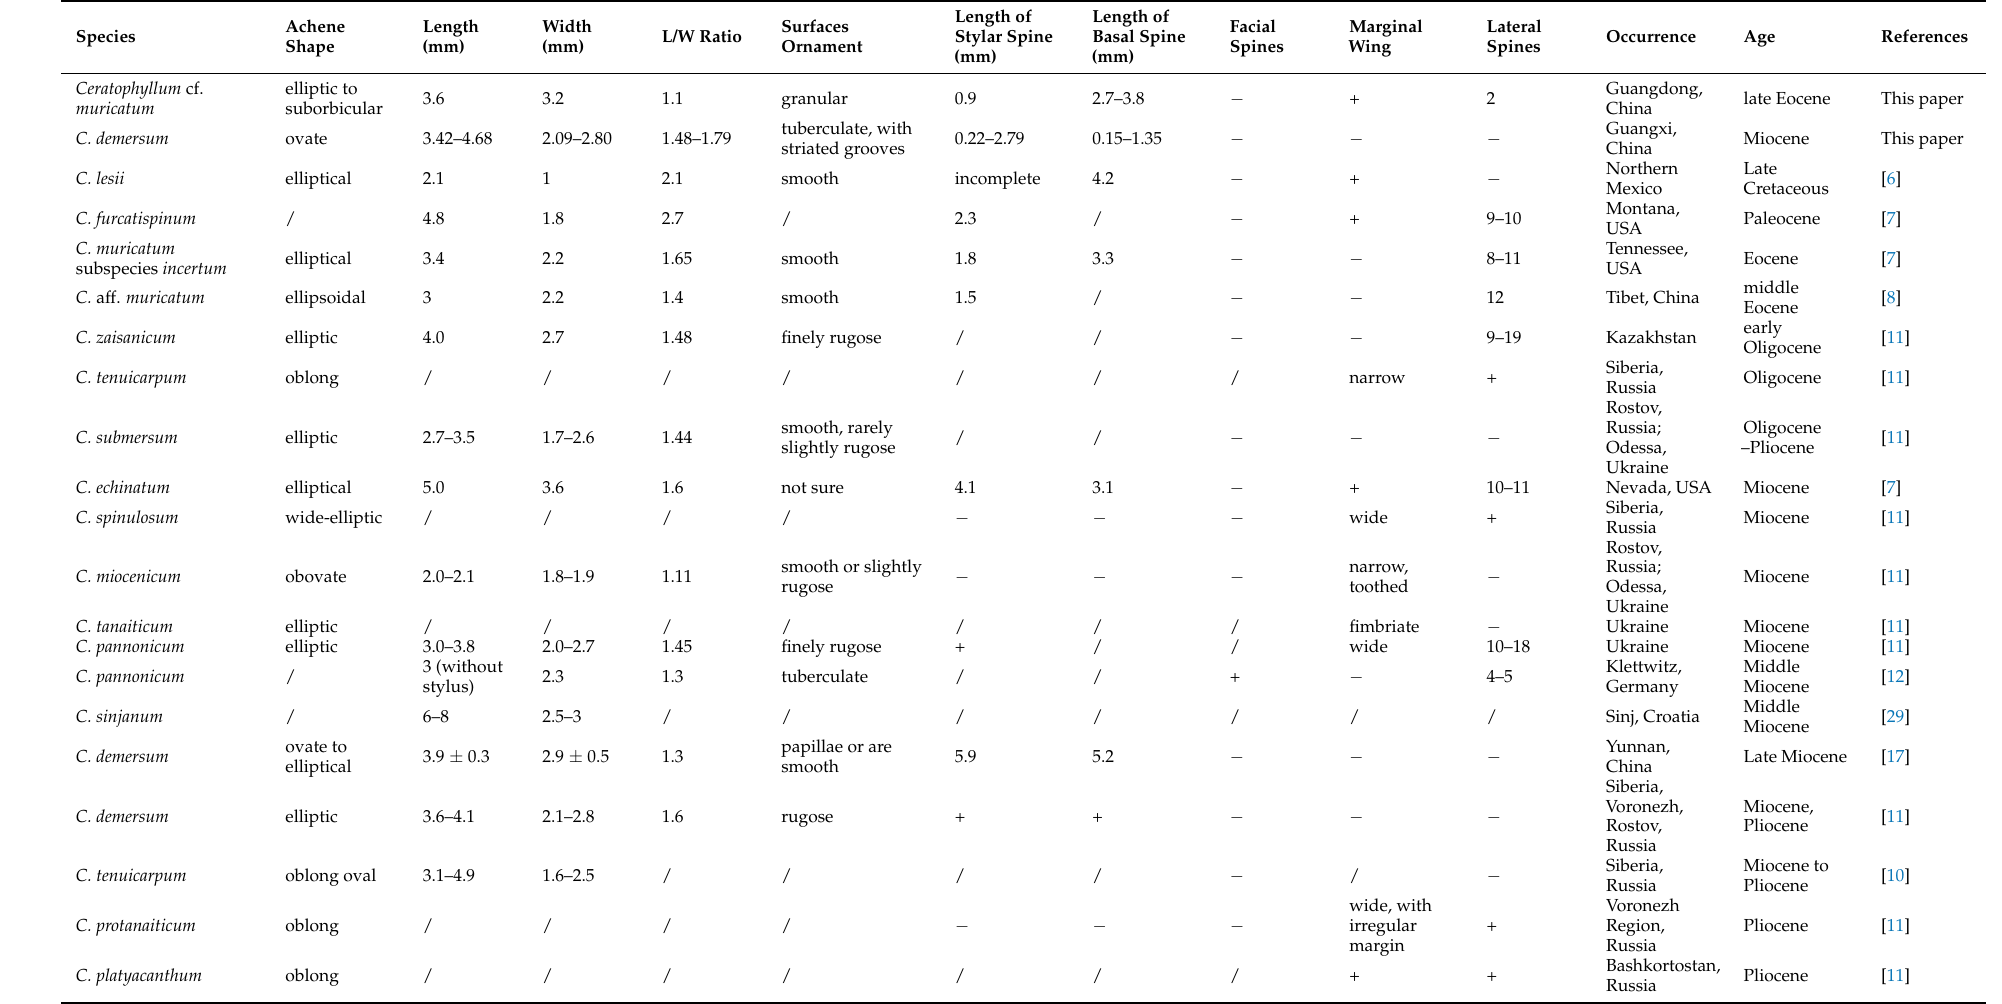
Table 1. Morphological comparison of two fruit fossils Ceratophyllum cf. muricatum Chamisso and C. demersum L. with other Ceratophyllum fruit